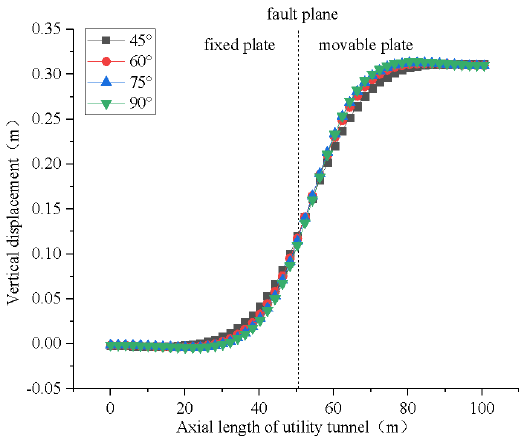
Figure 16. Schematic diagram of the size of the soil model of the integrated pipe gallery under 60° crossing angle (unit: m).